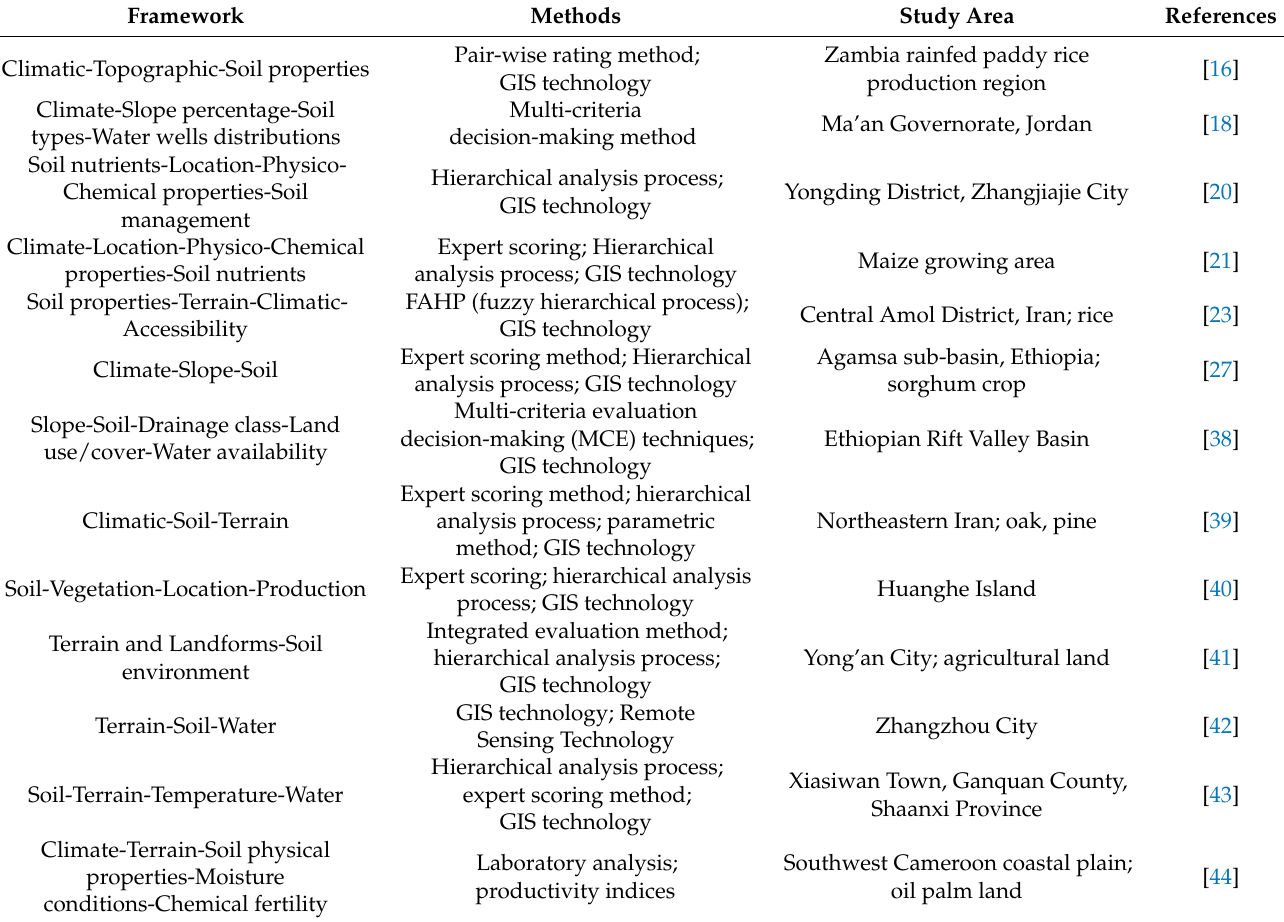
Table 1. Framework and methodology for